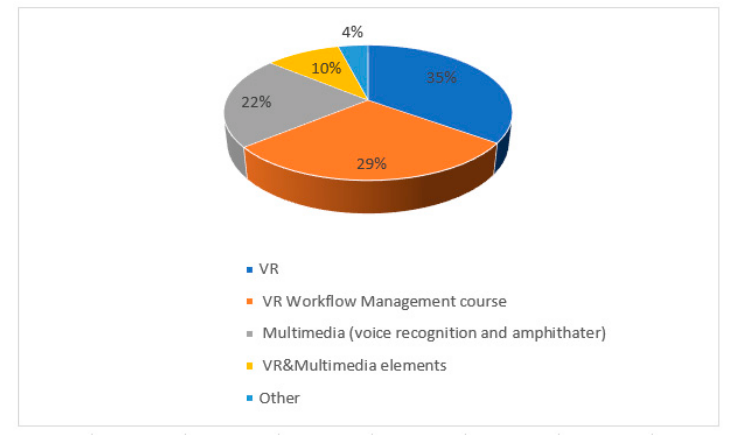
Figure 21. Motivation for watching the VR video.